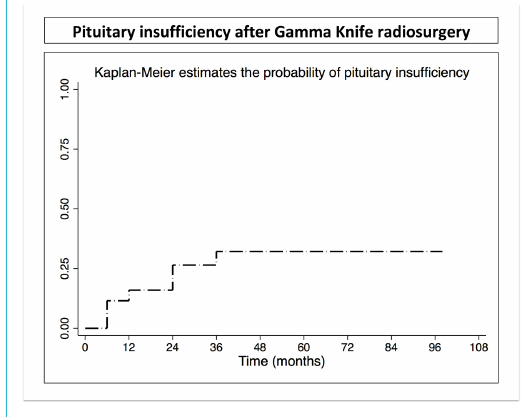
Figure 4: Probability of pituitary insufficiency after Gamma Knife